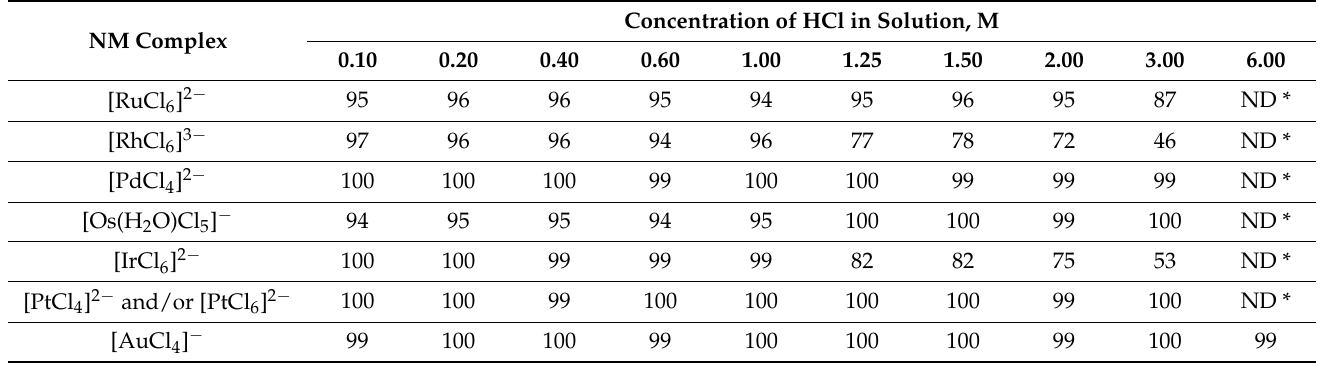
Table 3. Degrees of NM chlorocomplex sorption (S, %).